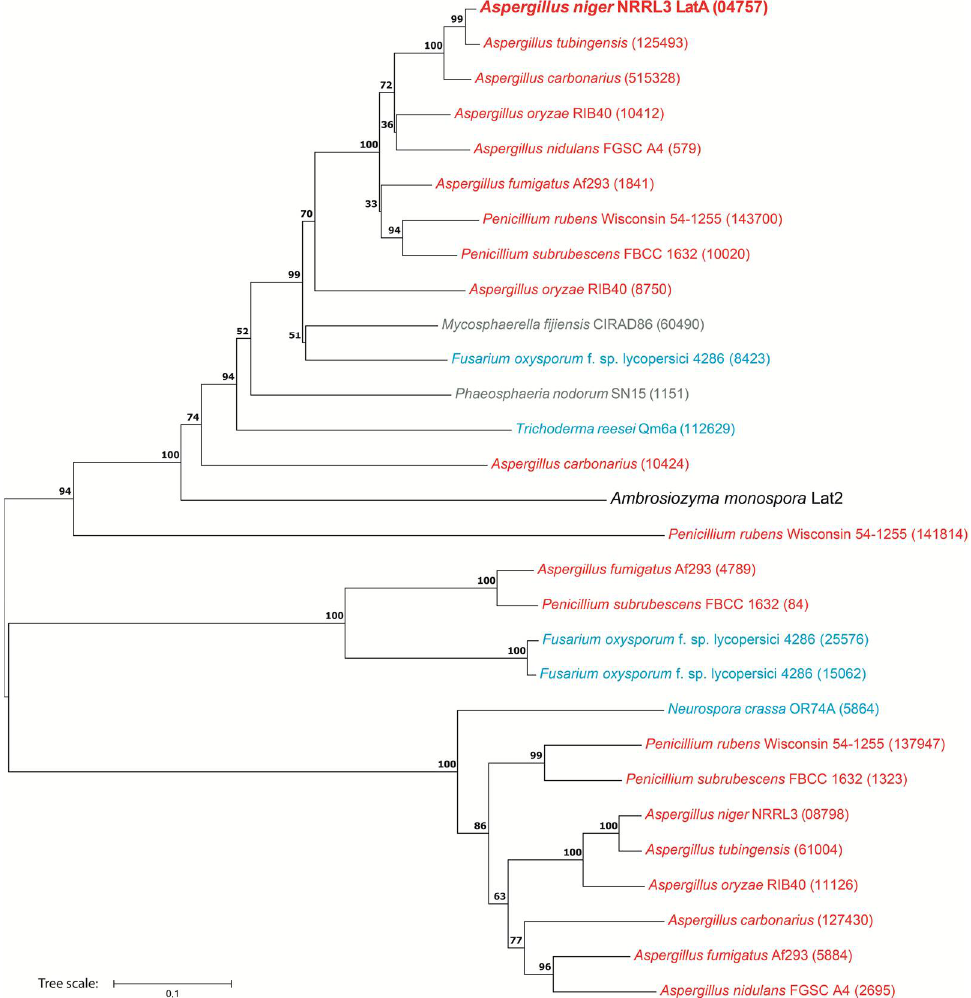
Figure 5. Unrooted phylogenetic tree of homologs of LatA from A. niger . The tree includes a specific L -arabinose transporter Lat2 from A. monospora (shown in larger font and black), the characterized L -arabitol importer LatA in A. niger (shown in larger font and boldface) and homologs of LatA in selected fungi. Bootstrap values are indicated on the nodes, which are supported by the Neighbor joining method. Colors represent the fungal taxonomic groups. Red = Eurotiomycetes, blue = Sordariomycetes, grey = Dothideomycetes. Numbers in brackets reflect the protein ID from JGI MycoCosm [38] .